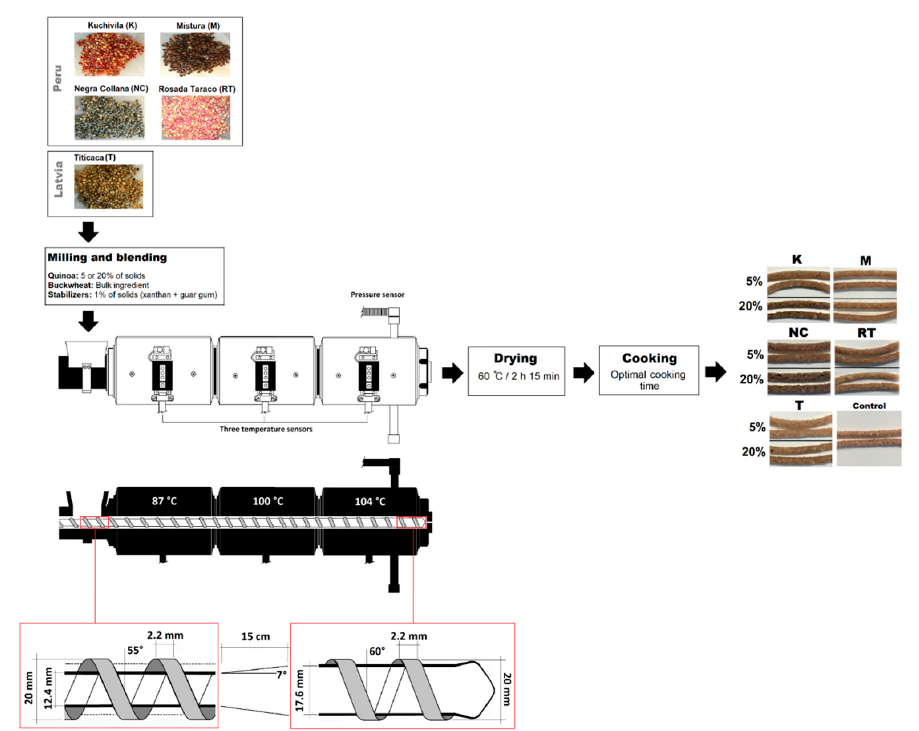
Figure 1. Flow chart for pasta production and technical description of the extruder (D = 20 mm, L/D 28:1). Sites for temperature/pressure monitoring are shown.